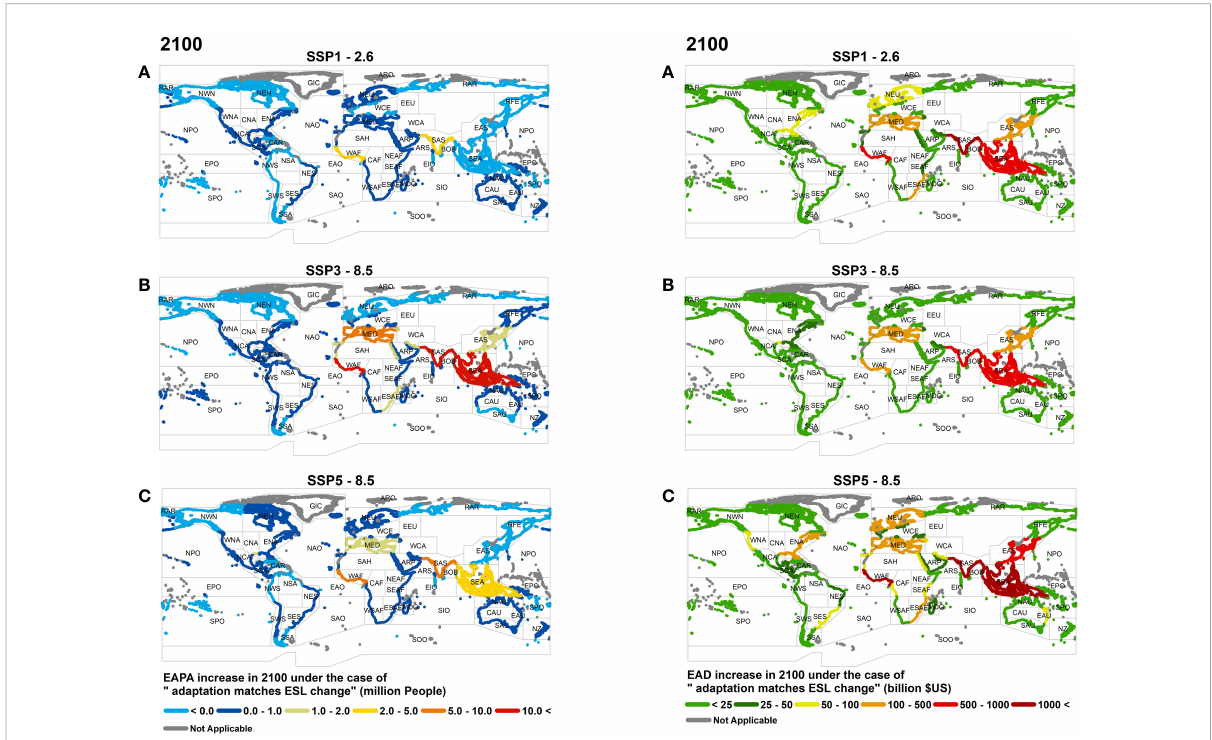
FIGURE 3 Changes in EAPA (left panels) and EAD (right panels) in 2100 for the scenario of adaptation matching ESL change , where adaptation measures increase over time at a rate which matches increases in ESL . Values shown represent the change relative to 2015. Panels show different Shared Socio-economic narratives (A) SSP1-2.6, (B) SSP3-8.5, (C)